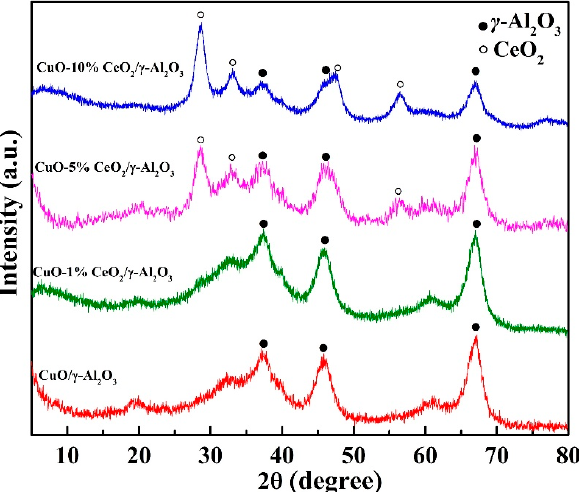
Figure 3. XRD patterns of CuO/ γ ‐ Al 2 O 3 , CuO ‐ 1% CeO 2 / γ ‐ Al 2 O 3 , CuO ‐ 5% CeO 2 / γ ‐ Al 2 O 3 , and CuO ‐ 10% CeO 2 / γ ‐ Al 2 O 3 .